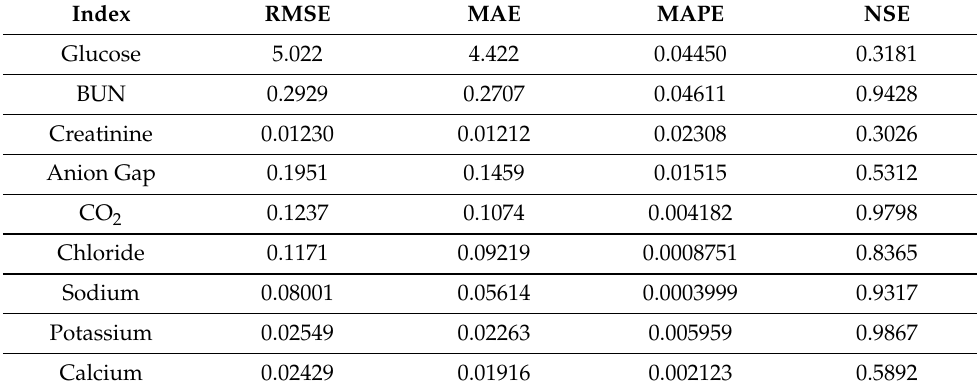
Table A4. Errors in other metrics of the one-step prediction of patient ESK.